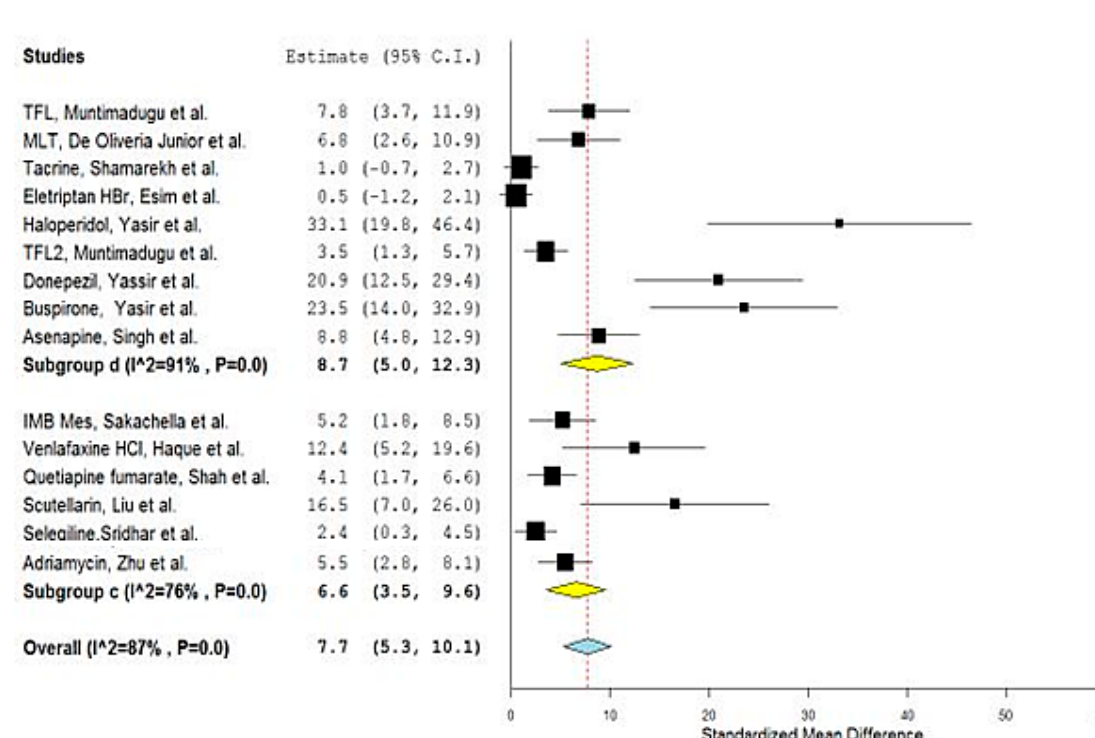
Figure 8. Forest plot of investigated subgroups: (c) naturally originated material of nanoparticulate systems versus (d) synthetically originated material of nanoparticulate system for the studies: [1–3,5–8,11–17,19], (OpenMetaAnalyst).